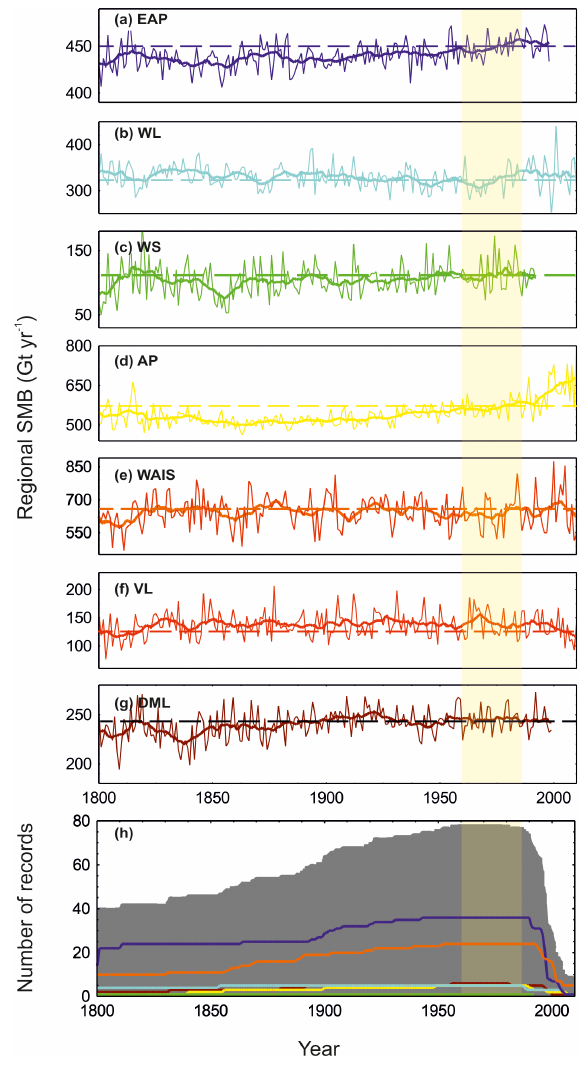
Figure 6. Regional SMB composites (1800–2010 AD) shown as annual averages (thin lines) and 5-year means (thick lines) for (a– g) the East Antarctic Plateau (EAP, dark blue); Wilkes Land coast (WL, cyan), Weddell Sea coast (WS, green), Antarctic Peninsula (AP, yellow), West Antarctic Ice Sheet (WAIS, orange), Victoria Land (VL, red), and Dronning Maud Land (DML, brown). Panel (h) represents the total number of records (solid grey) and the number of records by